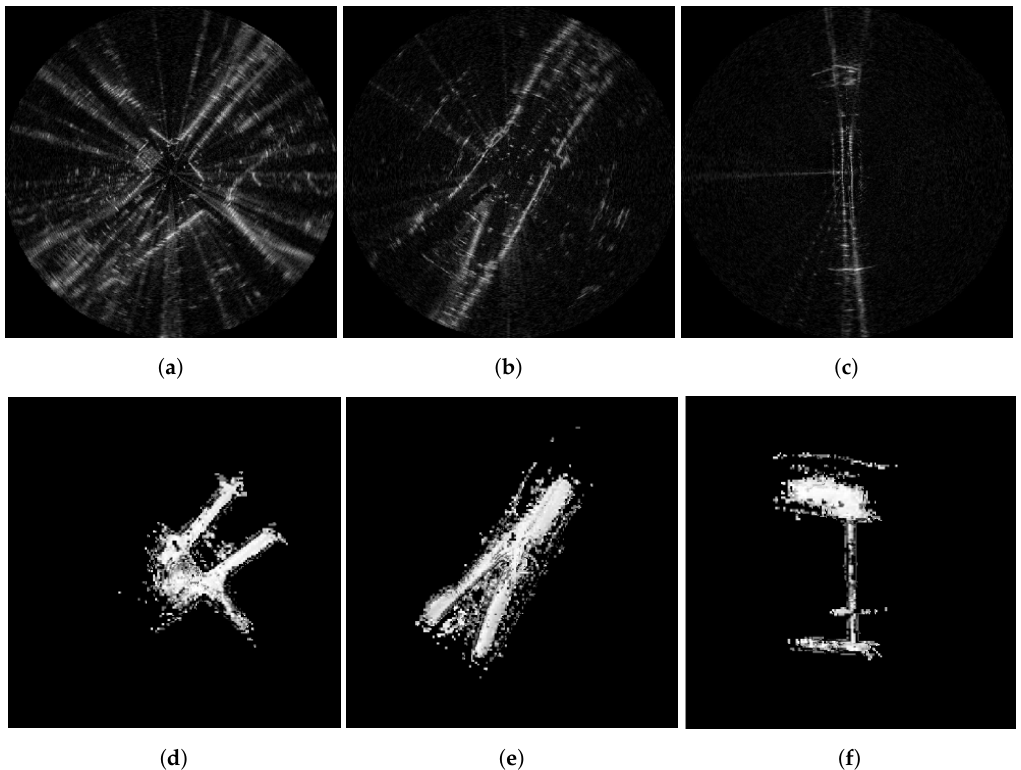
Figure 10. Radar scans ( a – c ) and corresponding traversability labels ( d – f ) captured and computed in three places featuring mixed urban canyon and open areas. Notice in these examples that radar sensory artefacts (e.g., the radiating saturation lines left, speckle noise middle, and duplicate south-to-north road boundary) are not featured in the dense accumulated point cloud. We thus expect the Neural Network (NN) model in Section 3.3 to learn a characterisation of the radar scan which is more intelligent than simply applying thresholds on the power (dB) return. The results shown in our first tested model (c.f. Section 6.1) confirm